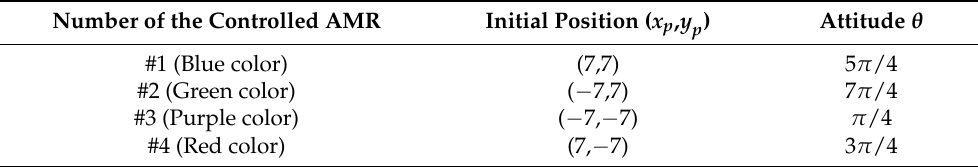
Table 2. Initial positions and attitudes of a swarm of AMRs.